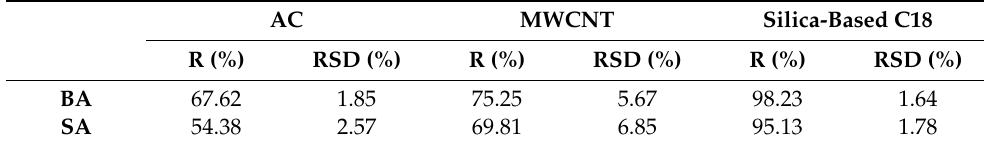
Table 10. Recovery percentages and the relative standard deviations (RSD%) of the three SPE methods